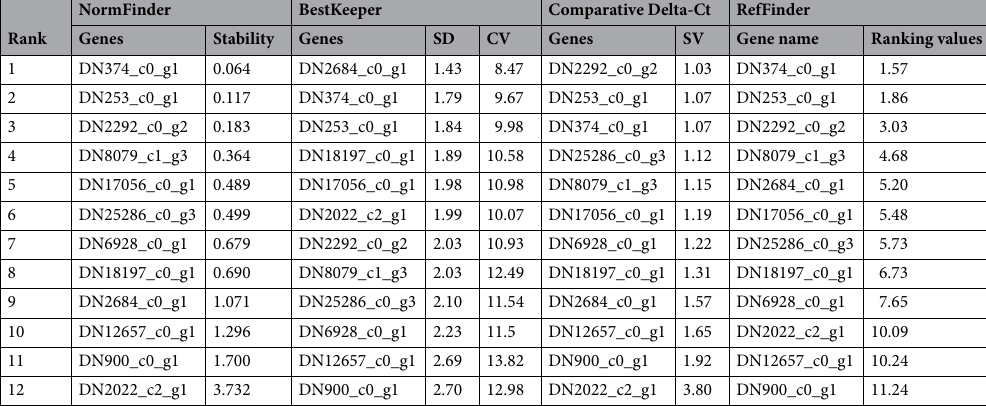
(Table 2). Despite the algorithm difference, the two aforementioned programs predicted that GLY 1 and SKP1 were the most stable genes while DN2022_c2_g1 was the least stable gene. BestKeeper analysis. BestKeeper assesses the stability of gene expression by comparing the standard devi- ation (SD) and the coefficient of variation (CV) of Ct values. Thereby, the most stable RG should have the lowest SD and CV according to the BestKeeper algorithm. The ranking result suggested that the top three stable genes were ACT2 , GLY1 , and SKP1 (Table 2), indicating that they were the best RGs for normalization.